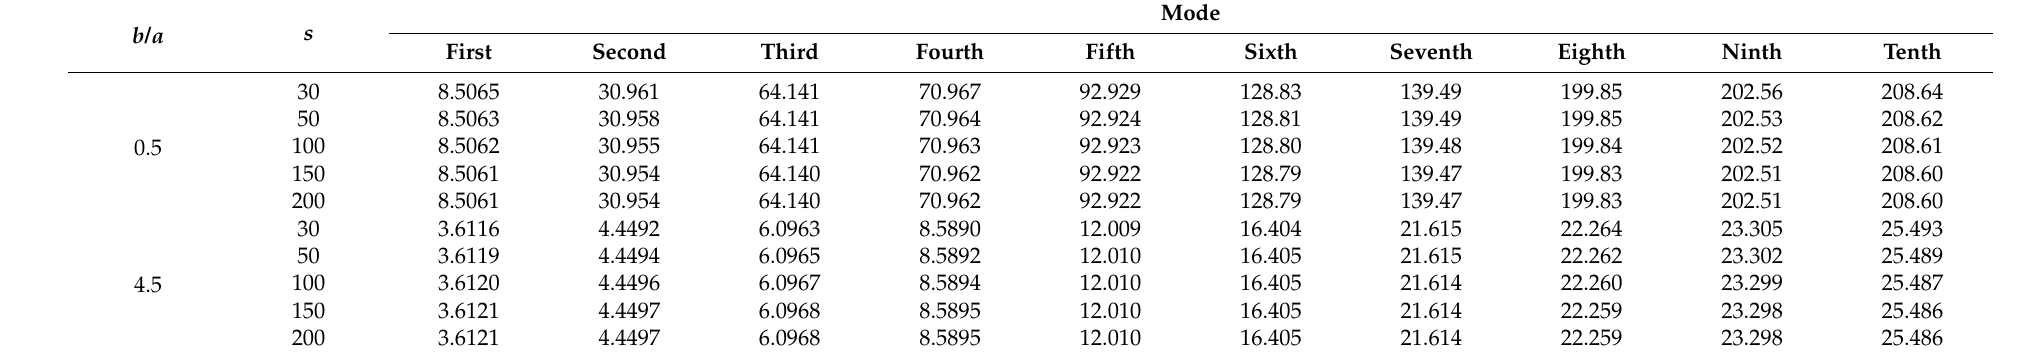
Table 8. Convergence of the dimensionless frequency parameter φ for the CSFF plates with aspect ratio χ equaling 0.5 and 4.5, respectively.